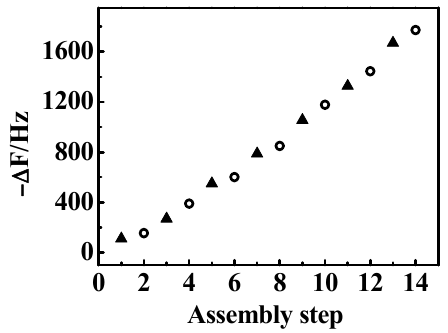
Figure 1. QCM frequency shift ( −Δ F) with assembly step of {Con A/GOD} n LbL films on Au/MPS/PDDA surface with adsorption steps: Con A ( ▲ ) and GOD ( ○ ).